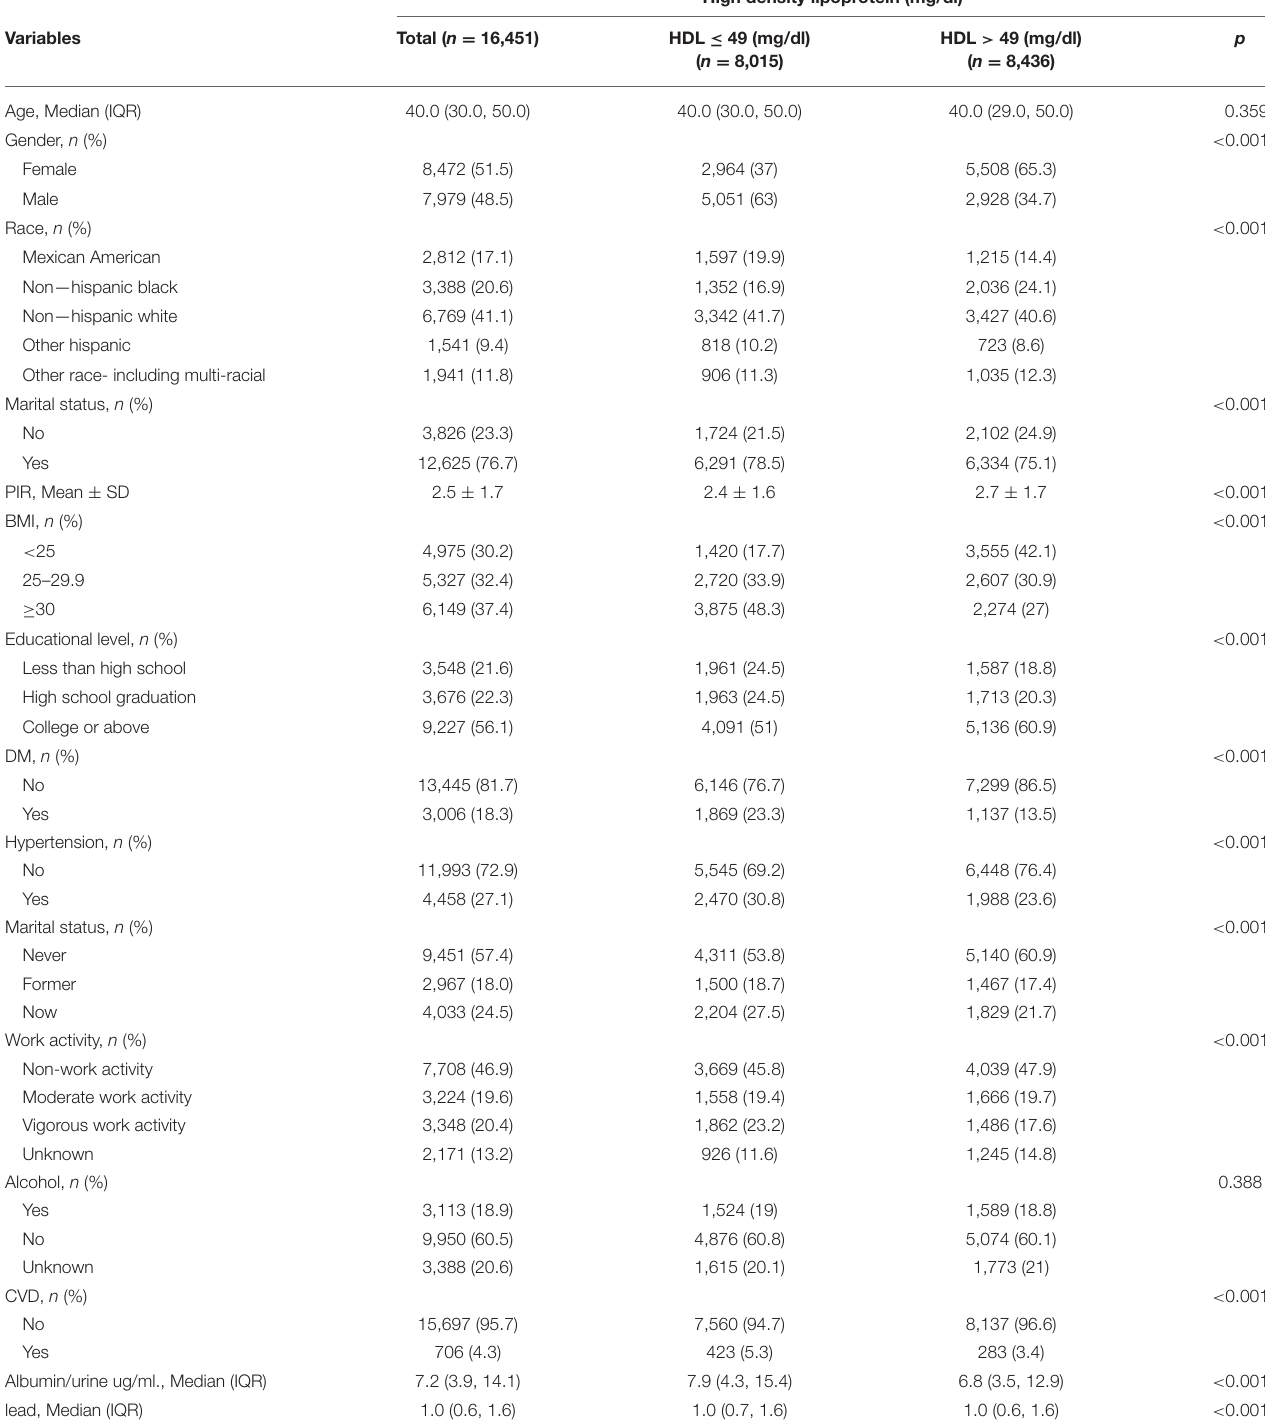
TABLE 1 | Baseline characteristics of the study